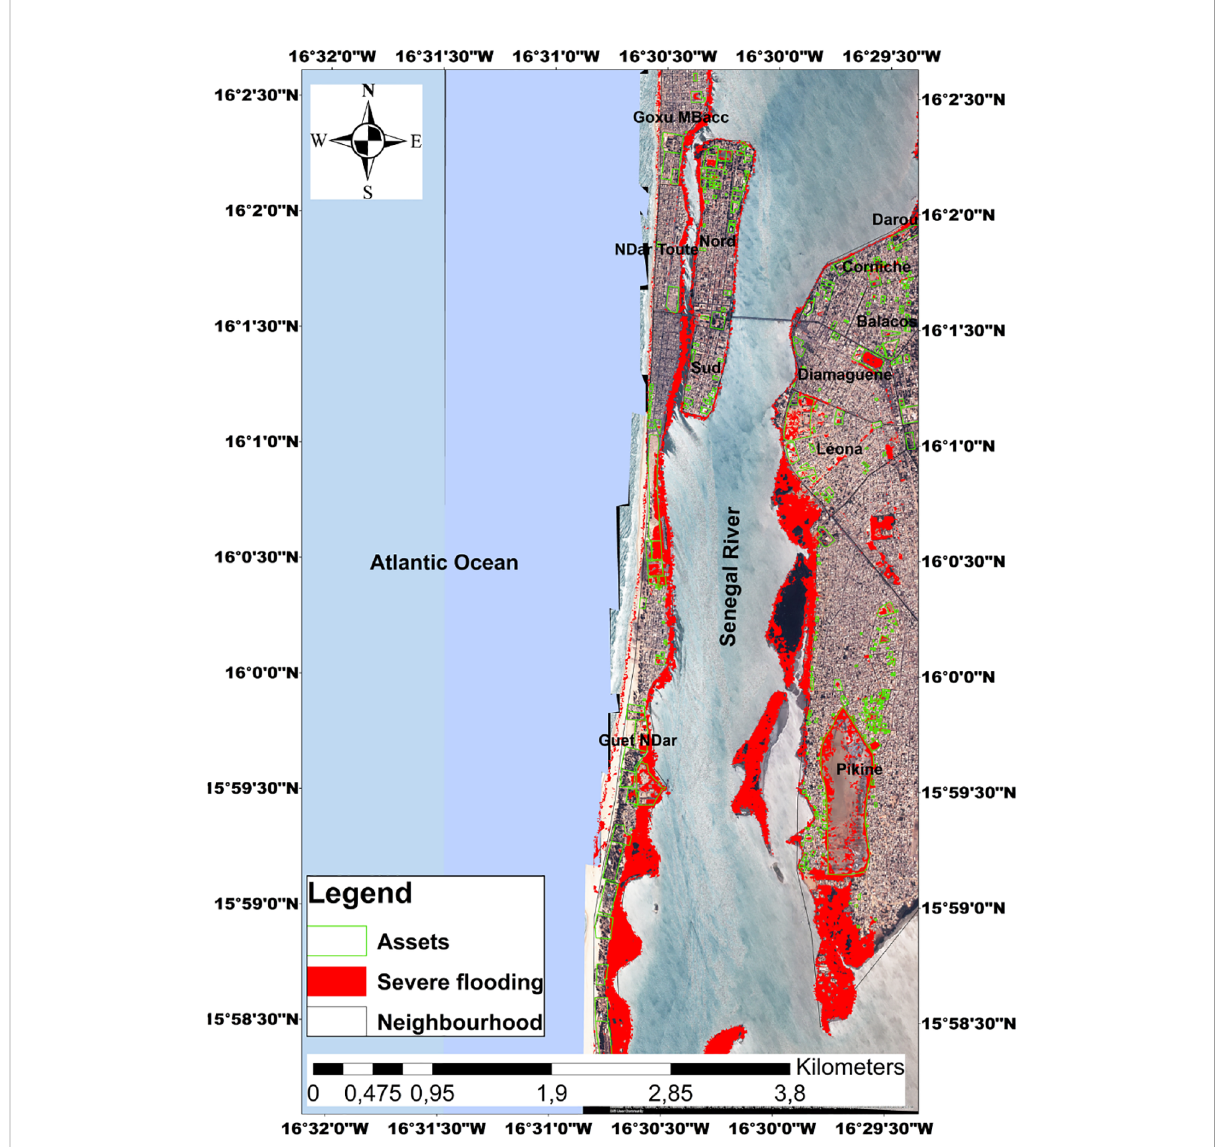
FIGURE 4 Map of infrastructures and assets of Saint Louis likely to be potentially fl ooded under the 98th ECWL percentile (i.e. 1.98